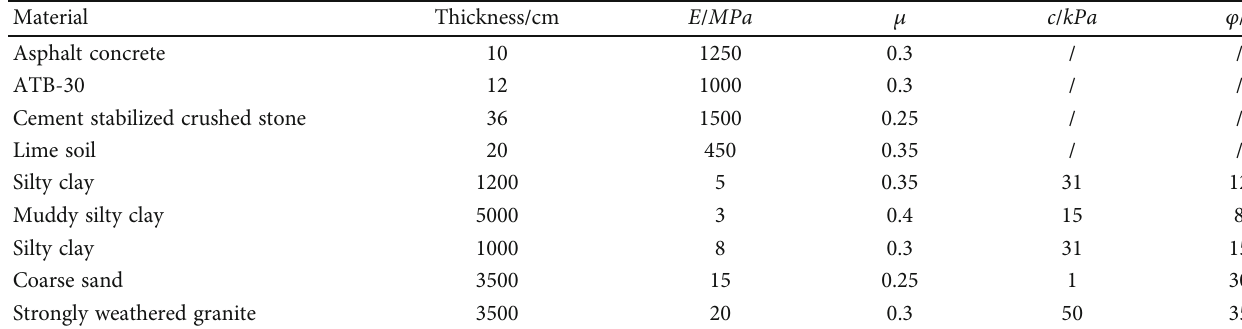
Table 3: Road and soil structure material parameters.